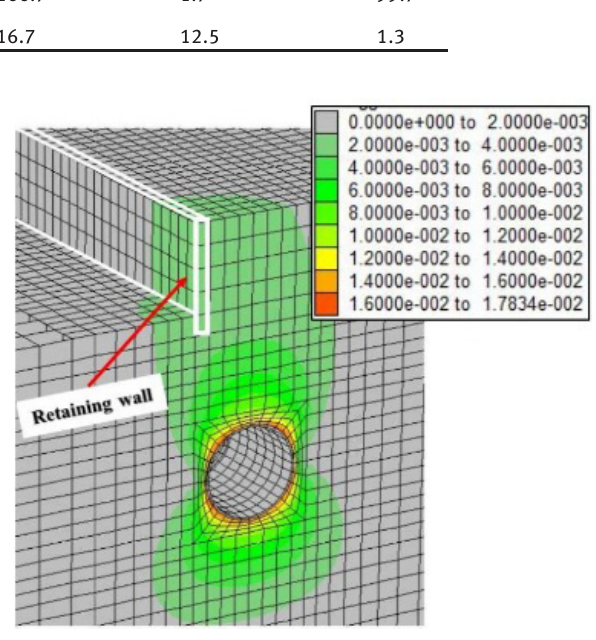
Figure 10: Contour of vertical displacements after complete installation of the shield (units: